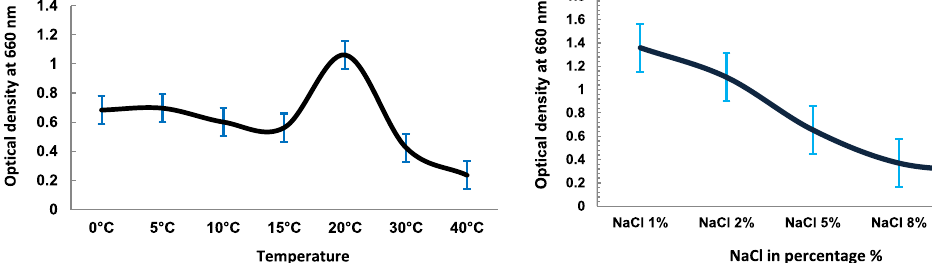
Fig. 4. NaCl Dependent growth of Kanchengayao glacier